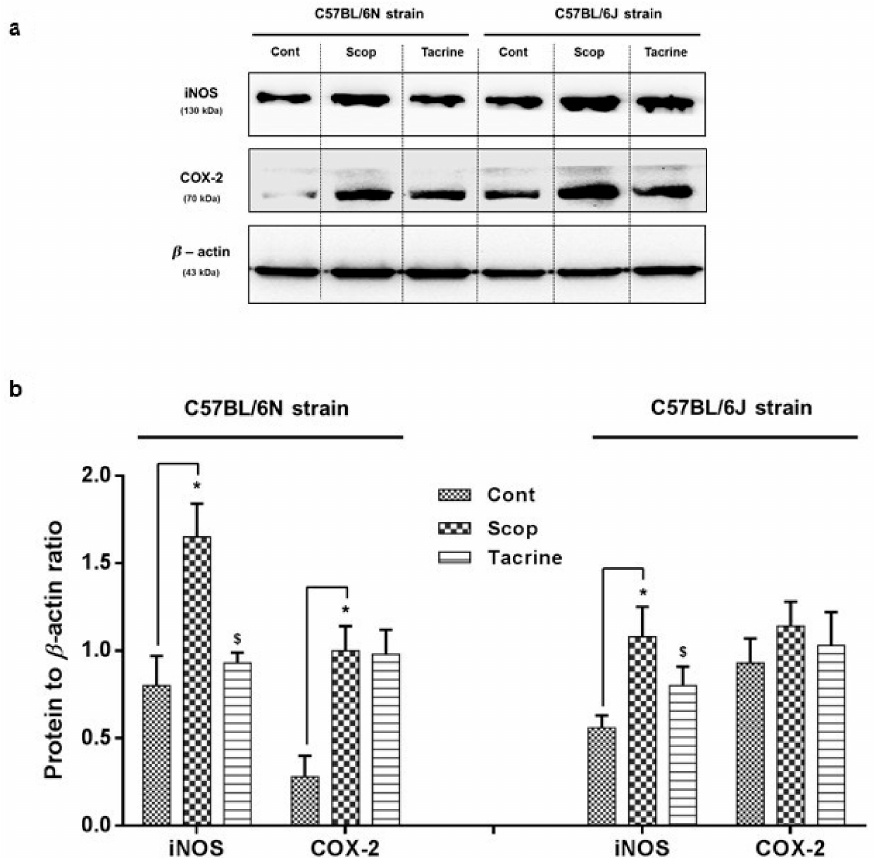
Figure 6. Inflammatory protein markers (iNOS and COX-2) expression in the hippocampus of scopolamine-induced amnesic models—C57BL/6N and C57BL/6J substrains: ( a ) Western blotting of inflammatory protein expression and ( b ) its quantification relative to β -actin expression. Data are expressed as mean ± SD ( n = 3). One-way ANOVA-Tukey’s multiple comparison test was performed where, * p < 0.05 scopolamine compared with the control group; $ p < 0.05 tacrine compared with scopolamine-treated